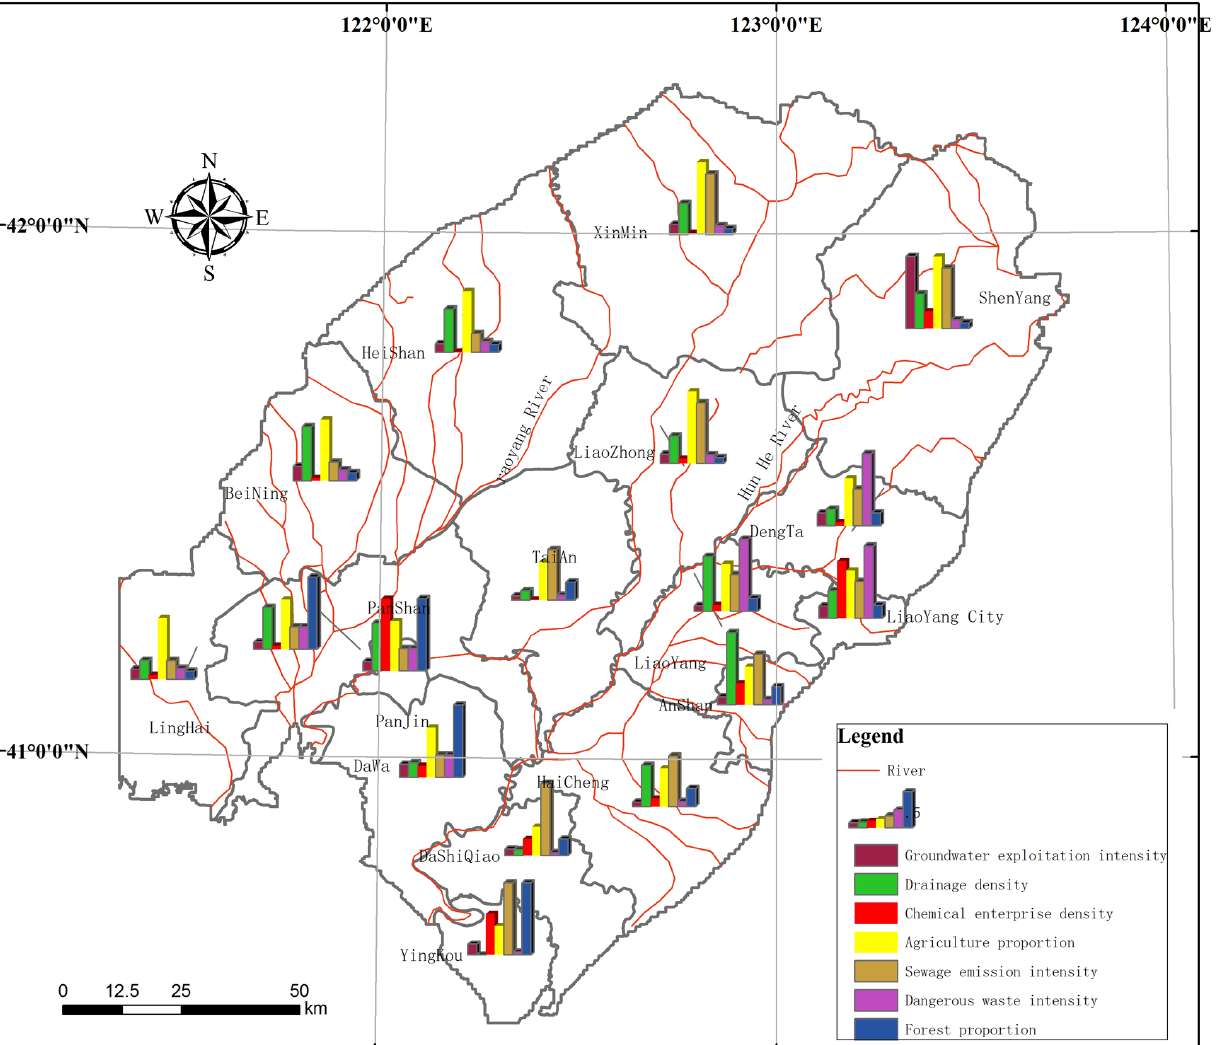
Fig 6. Risk source normalization in the study